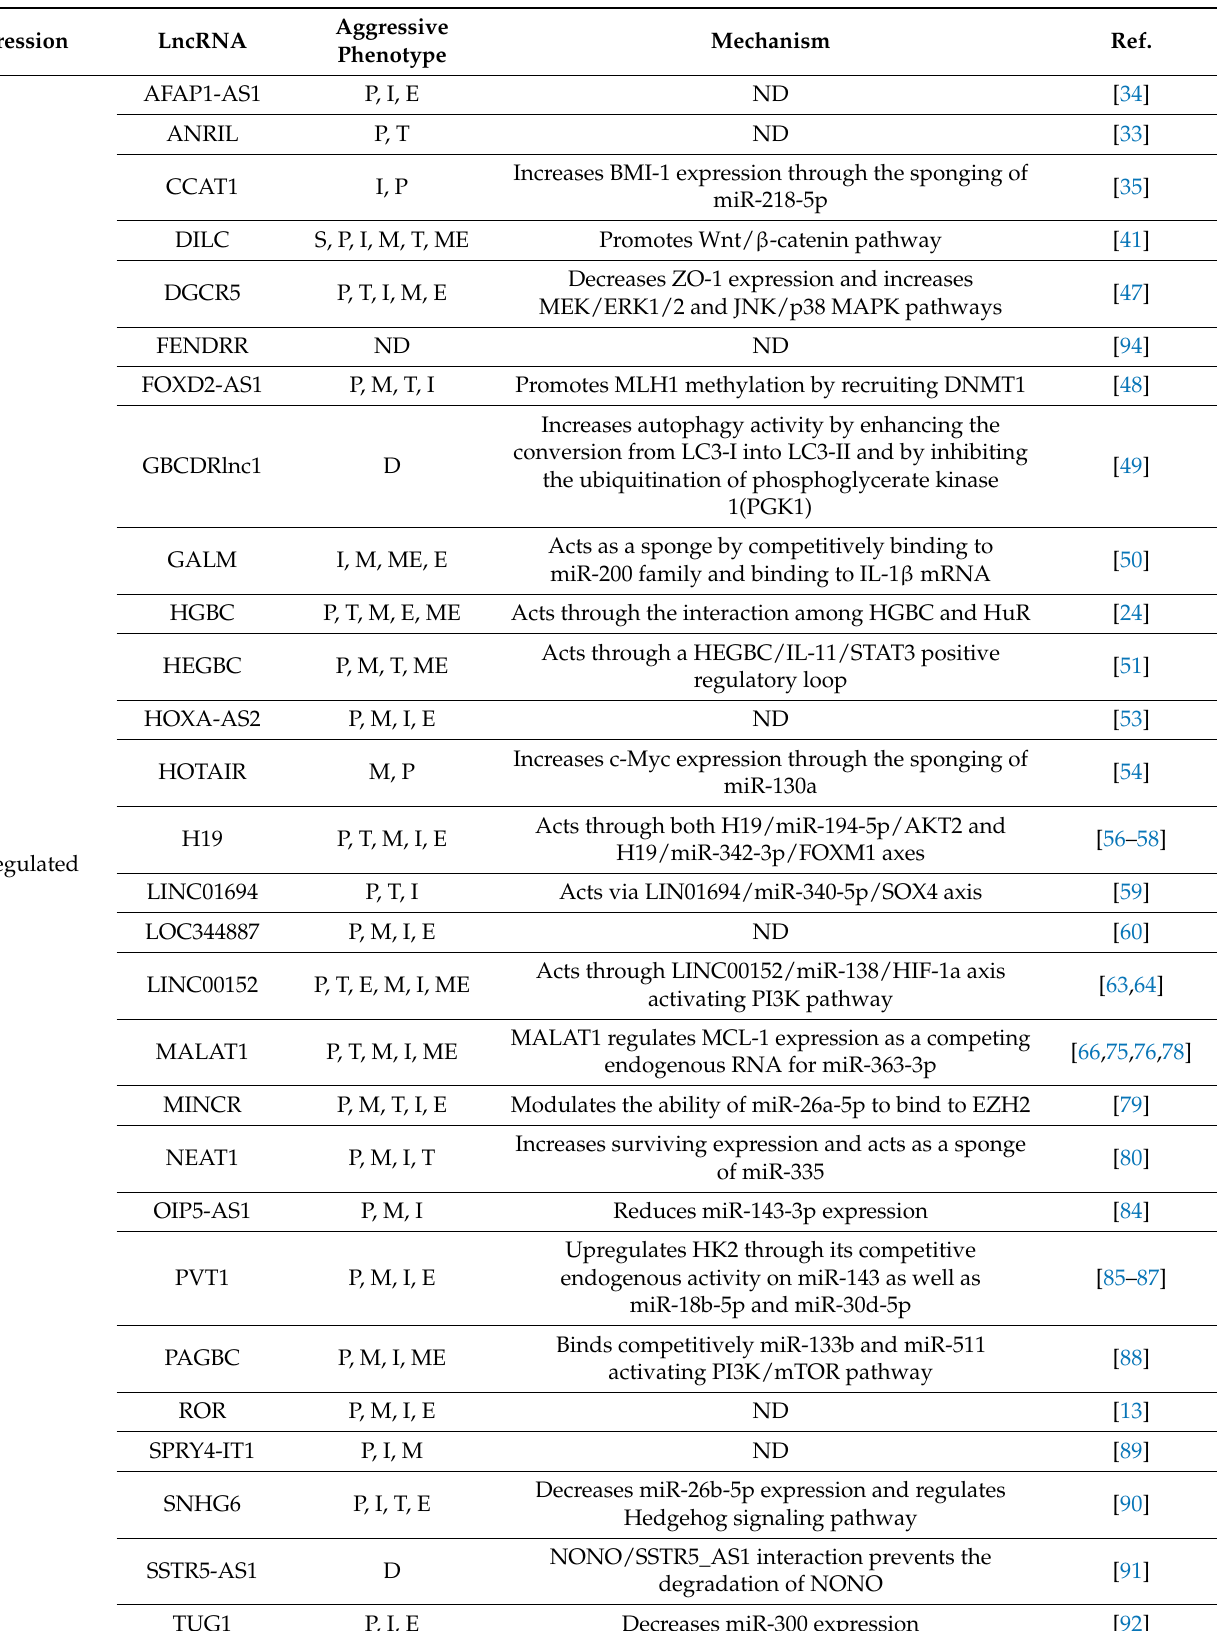
Table 1. Resume of lncRNAs related to an aggressive phenotype on gallbladder cancer.